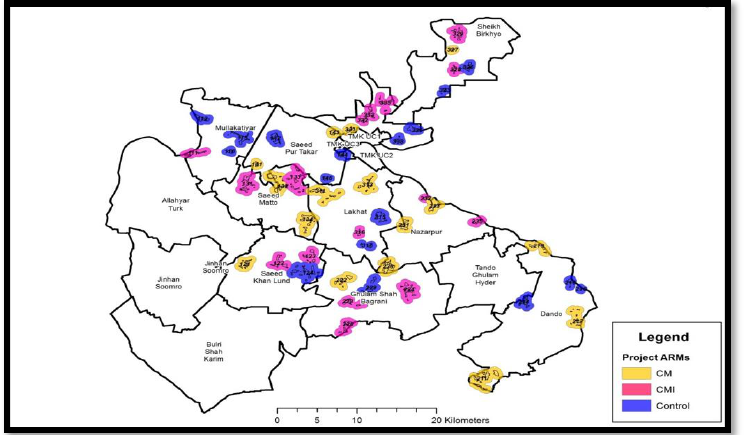
Figure 3. Geographic dispersion of clusters by the three study groups. CM: Community Mobilization; CMI: Community Mobilization and Incentivization.